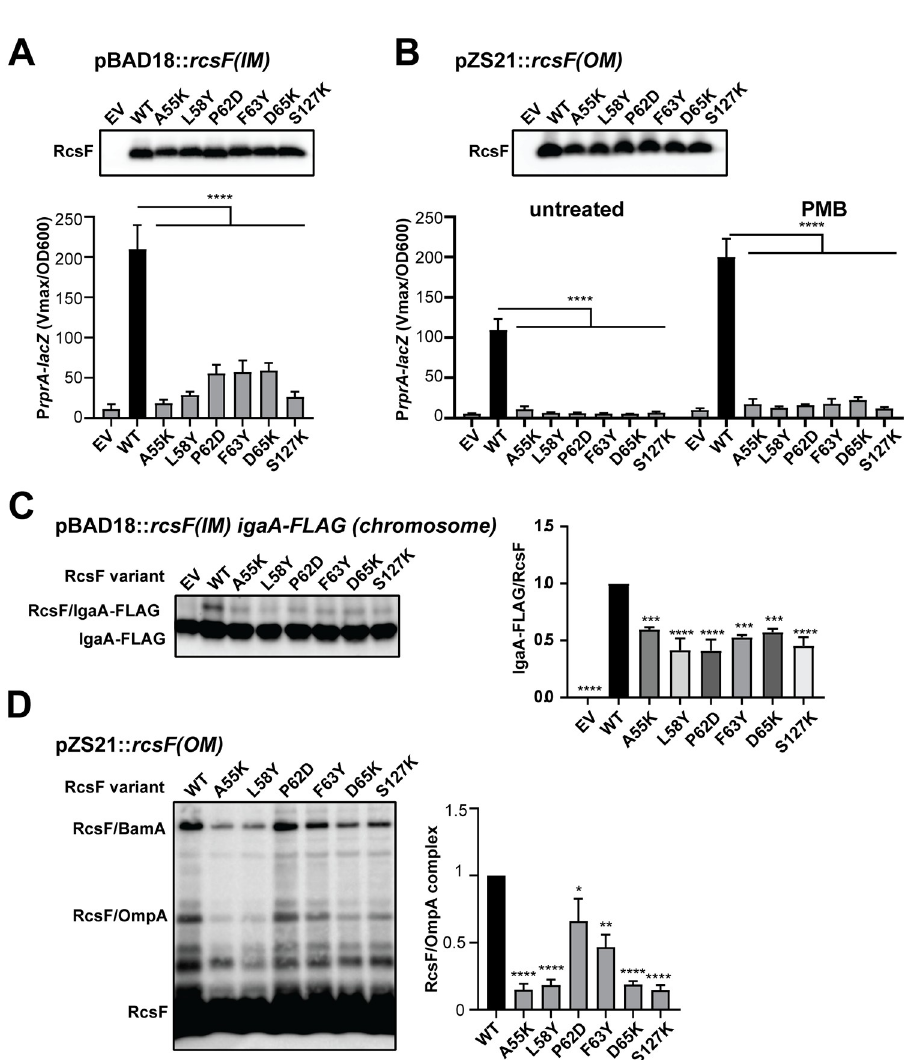
Fig 3. Characterization of RcsF LOF[IM] variants. LOF[IM] mutations were introduced on a plasmid encoding IM (A) or OM (B) versions of rcsF and analyzed by immunoblotting with α -RcsF antibodies and by a β -galactosidase assay using P rprA-lacZ transcriptional reporter. Where indicated, strains were treated with 0.75 μ g/ml PMB for 40 min. Graphs represent mean β -galactosidase activity normalized to OD600, +/- standard deviation (SD). (C) LOF[IM] mutations were introduced into IM localized RcsF and tested for crosslinking to the chromosomally encoded IgaA-FLAG. Immunoblot analysis of in vivo formaldehyde crosslinked samples probed with α -FLAG. RcsF/IgaA band was quantified relative to the WT. Graph represents mean of independent experiments +/- SD. (D) LOF[IM] mutations affect RcsF/OmpA crosslinking. Immunoblot analysis of in vivo formaldehyde crosslinked samples probed with α -RcsF antibodies (left). Immunoblot quantification of RcsF/OmpA relative to the WT (right). Graphs represent mean of three independent experiments +/- SD. Significance throughout this figure is indicated in comparison to the WT as follows: n.s. = p � 0.05, � = p < 0.01, �� = p < 0.01, ��� = p < 0.001. ���� = p < 0.0001. ND = not determined. For additional significance comparison of data (A) and (B) see S2